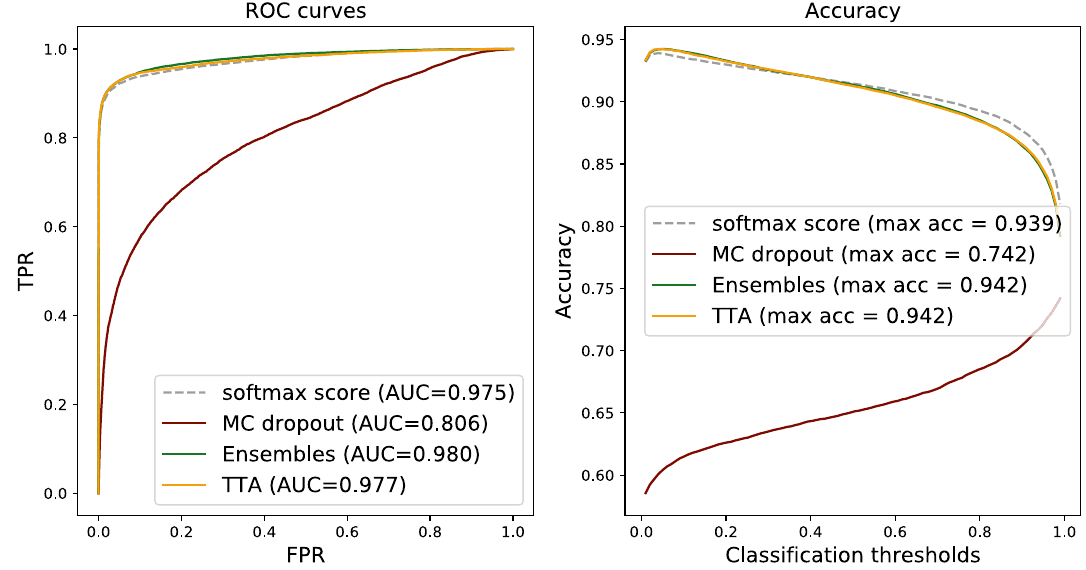
Figure 1. Tumour metastases detection on Camelyon16 data: ROC curves and accuracy of using softmax tumour score from a single NN vs averages of softmax tumour scores (per input) produced by the uncertainty estimation methods.